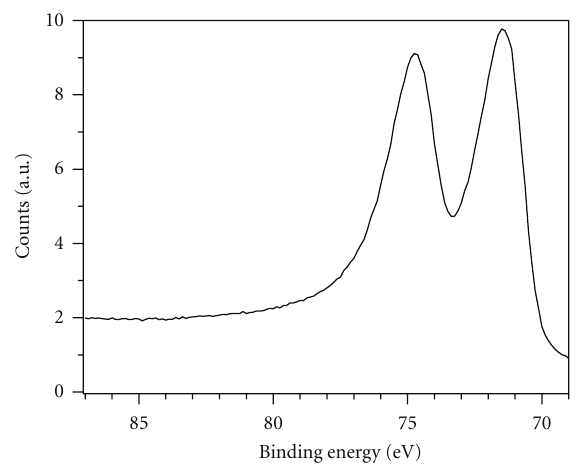
Figure 3: High-resolution XPS spectrum of Pt(4f) line on ULPt(90s).